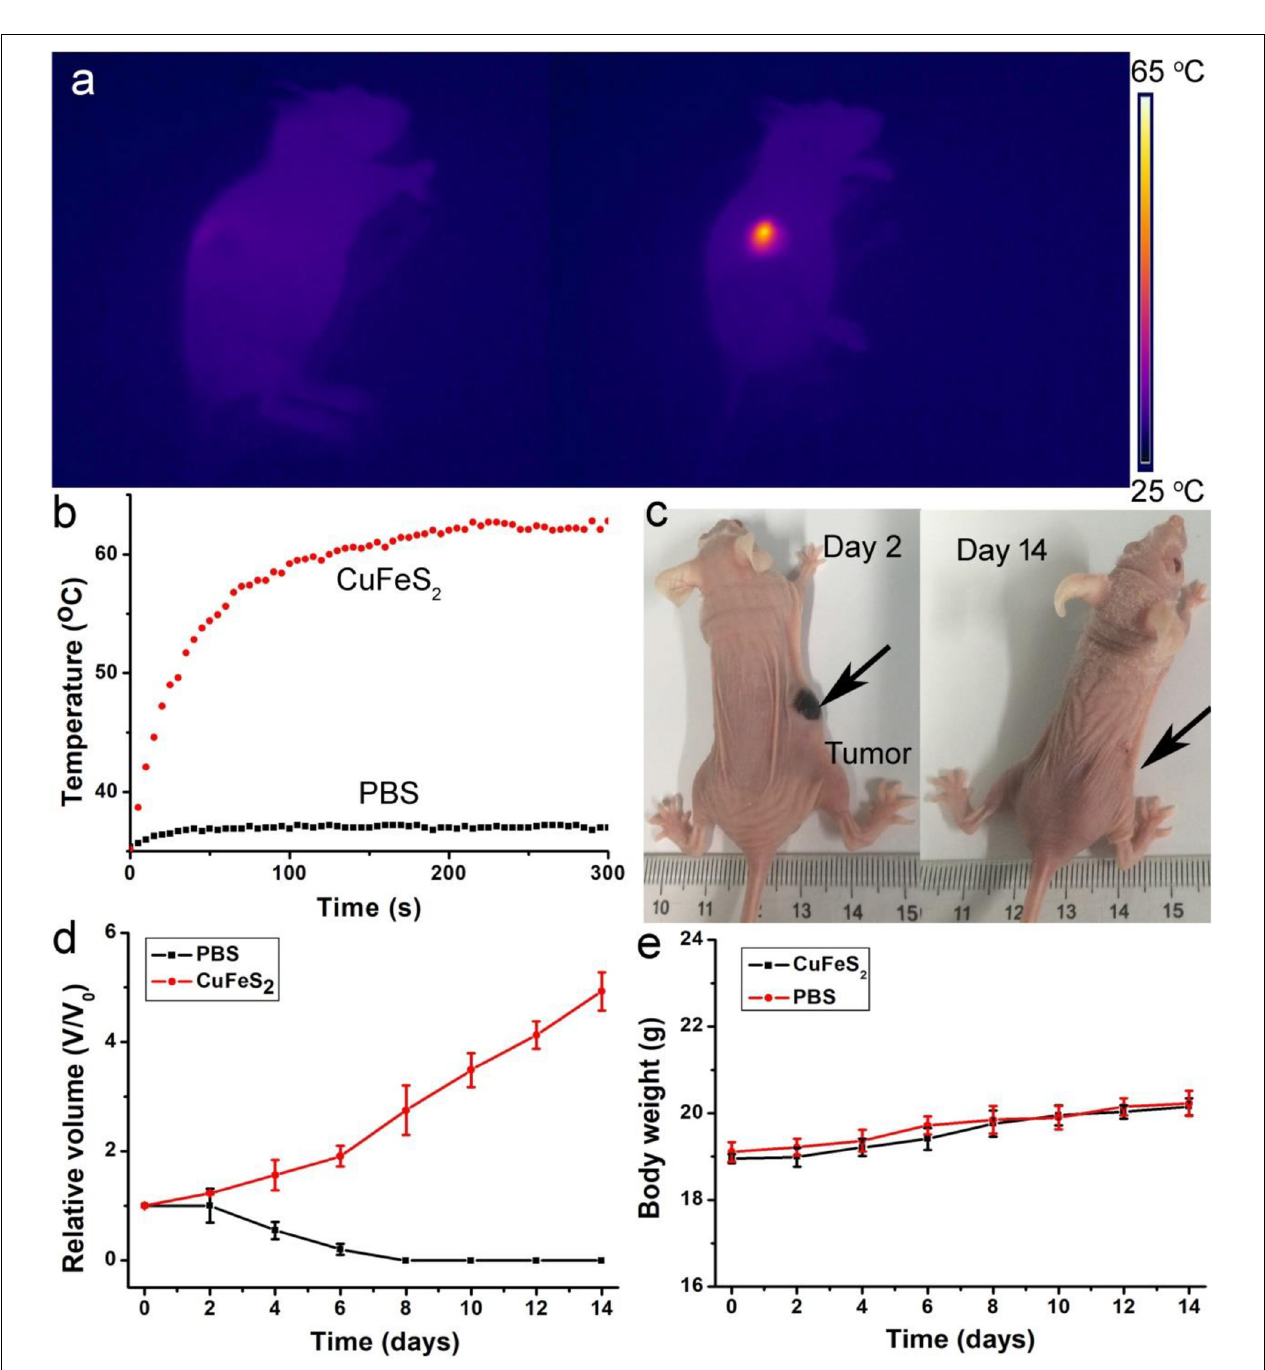
FIGURE 6 | (a) Thermal image of a mouse body showing the tumor area injected with PBS (left) and CuFeS 2 nanoassemblies (right) and exposed to 808 nm NIR laser irradiation. (b) Typical temperature elevation curves of the treated tumors. (c) Photographs of mice after photothermal therapy. (d) Growth curves of tumors over time in the two groups after the treatments. (e) Body weight curves over time in the two groups after the treatments.